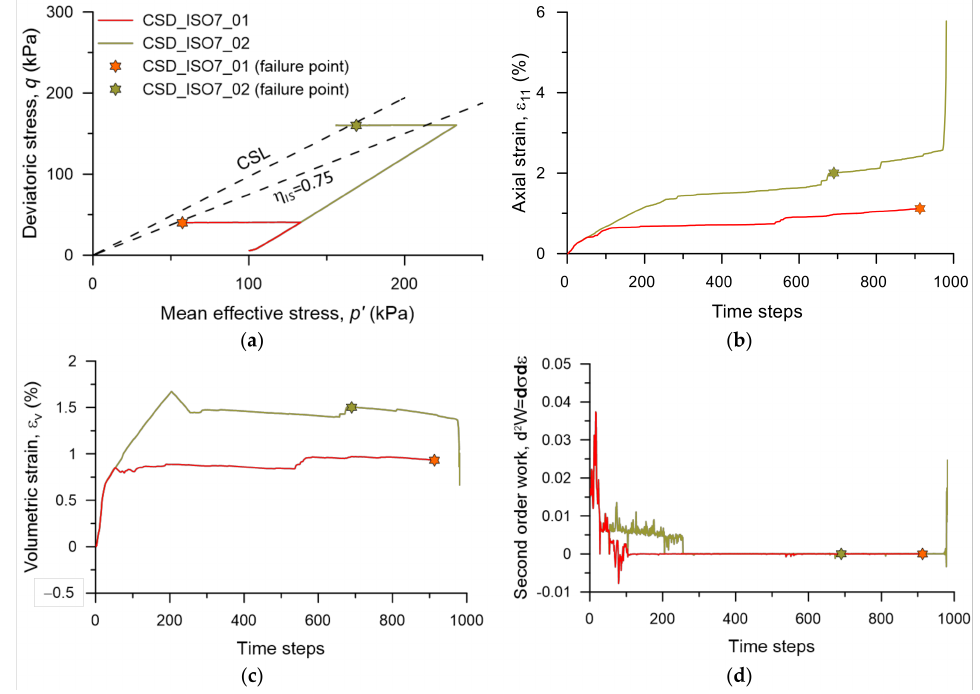
Figure 7. The CSD simulations with the same initial state with ISO7 in ( a ) q - p (cid:48) , ( b ) ε 11 , ( c ) ε v and ( d ) d 2 W